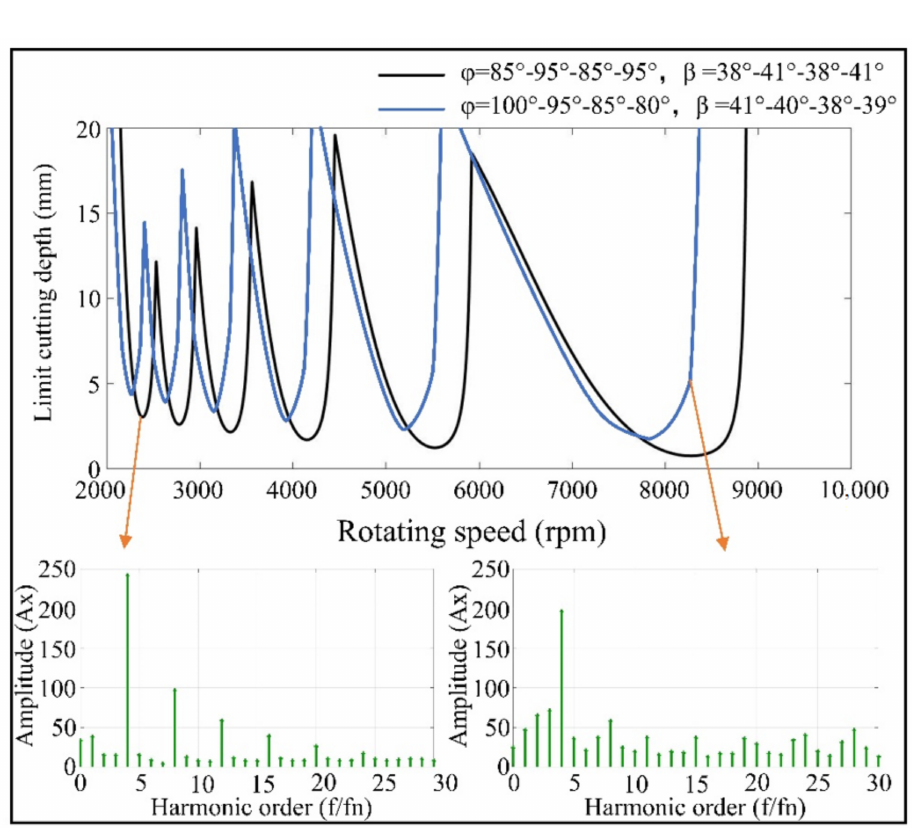
Figure 2. Lobes and spectrum in tool